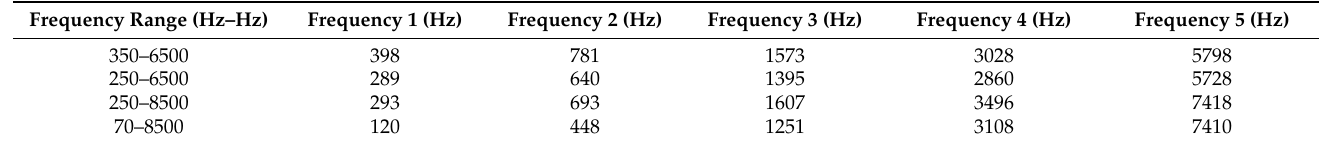
Table 1. Selection of